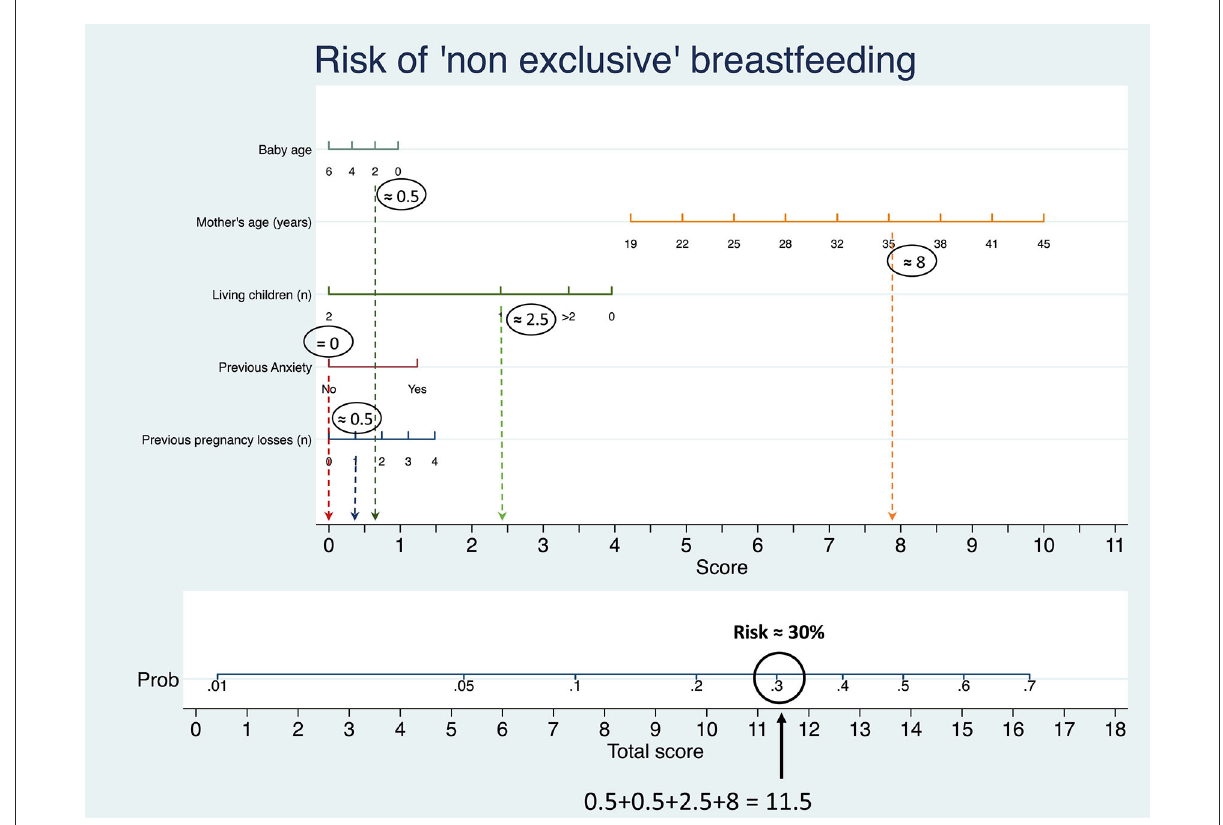
FIGURE6 Nomogram derived by logistic regression of probability of not exclusively breastfeeding according to baby’s age, mother’s age, number of living children, presence of previous anxiety and number of previous losses.